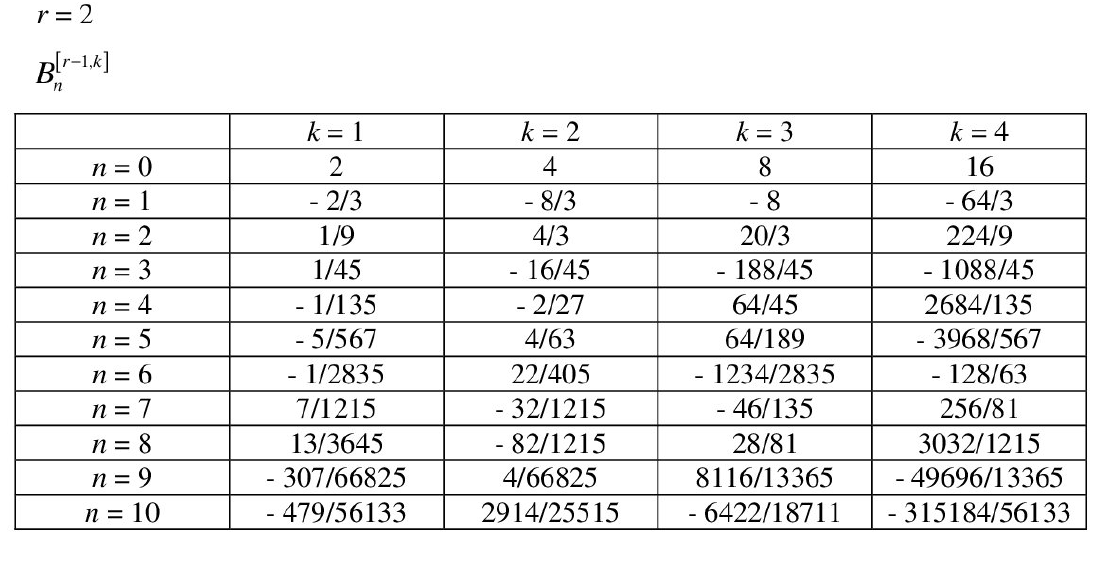
[ 1, k ] = 1,2,3,4; n = 0,1, . . . ,10. n ; k